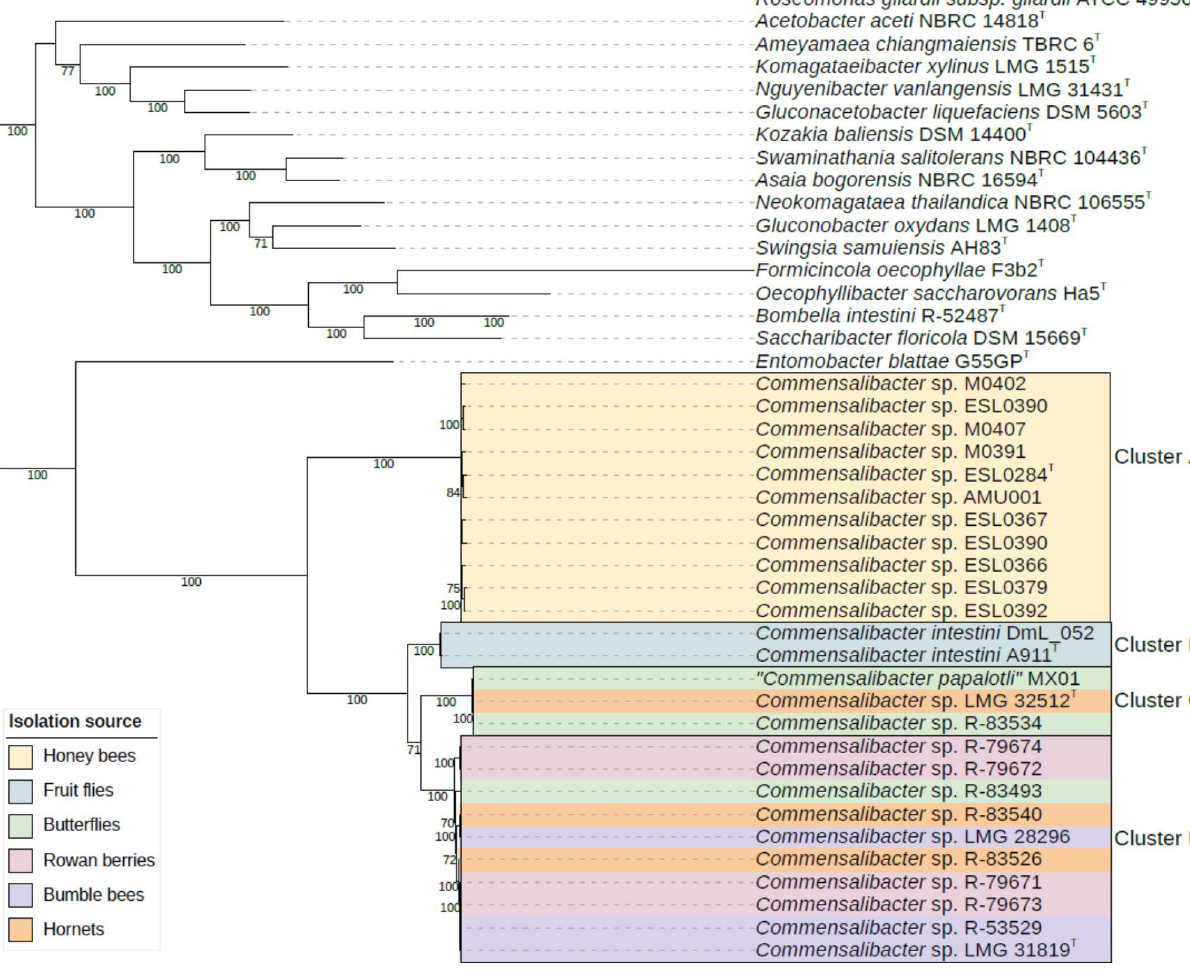
Fig. 1 Maximum-likelihood bcgTree tree based on 107 core genes showing the phylogenomic relationships between the Commensalibacter and repre- sentative phylogenetic neighbor taxa. Bootstrap percentages above 70% (1000 replicates) are shown next to the branch points. The color bar indicates isolation sources. Superscript ‘T’ denotes taxonomic type